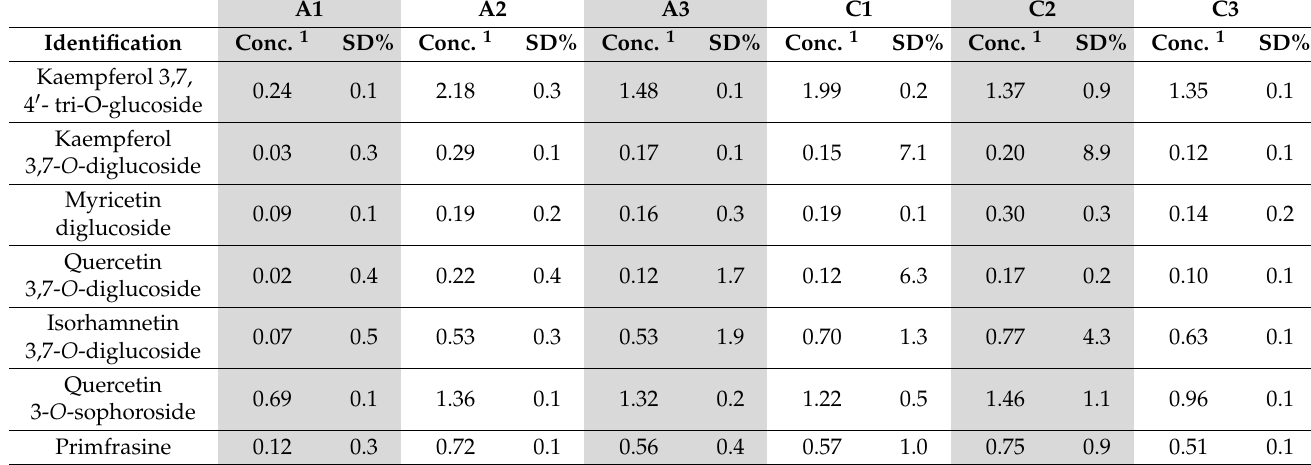
Table 3. Quantification of flavonols by using UPLC-DAD-ESI-MS expressed as mg of kaempferol 3-O-glucoside equivalent per gram of DW of raw material. Each sample was extracted in triplicate and individually analysed. The standard deviation was calculated on three replicates.